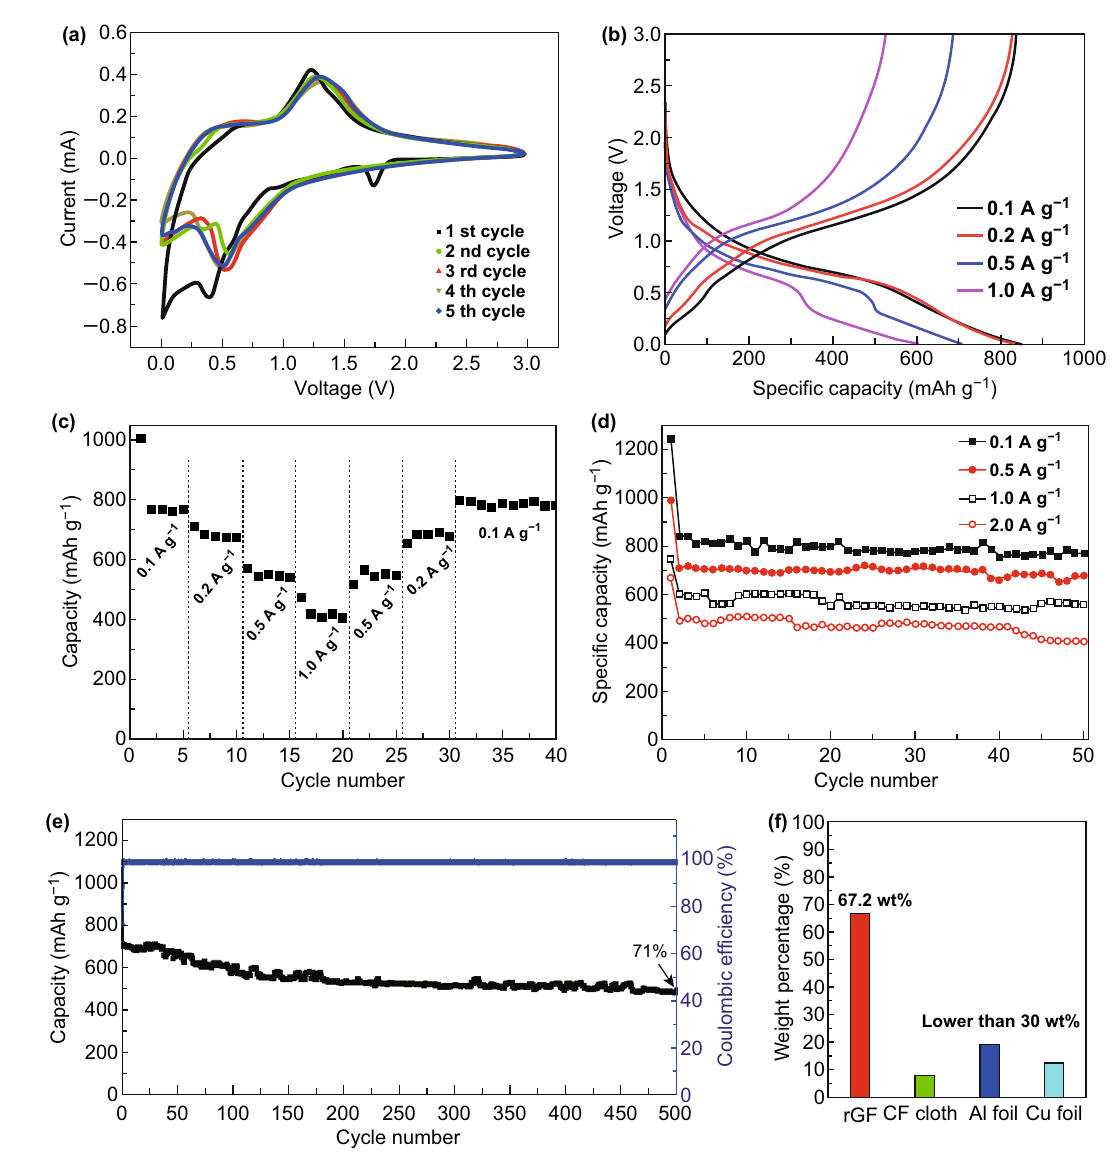
Fig. 4 a Cyclic voltammograms, b the 2nd discharge/charge curves at different current rates and c the rate performances of the SnS 2 @rGF electrode. d Rate capability of the SnS 2 @rGF anodes with cycles. e Long‑term cycle performance of the SnS 2 @rGF electrode at a current rate of 0.5 A g −1 . f Comparison of the estimated weight percentage of SnS 2 in electrodes using different current collectors, including the commonly employed CF cloth (CeTech, WOS1002), Al foil (18 µm in thickness), Cu foil (9 µm in thickness), and our rGF